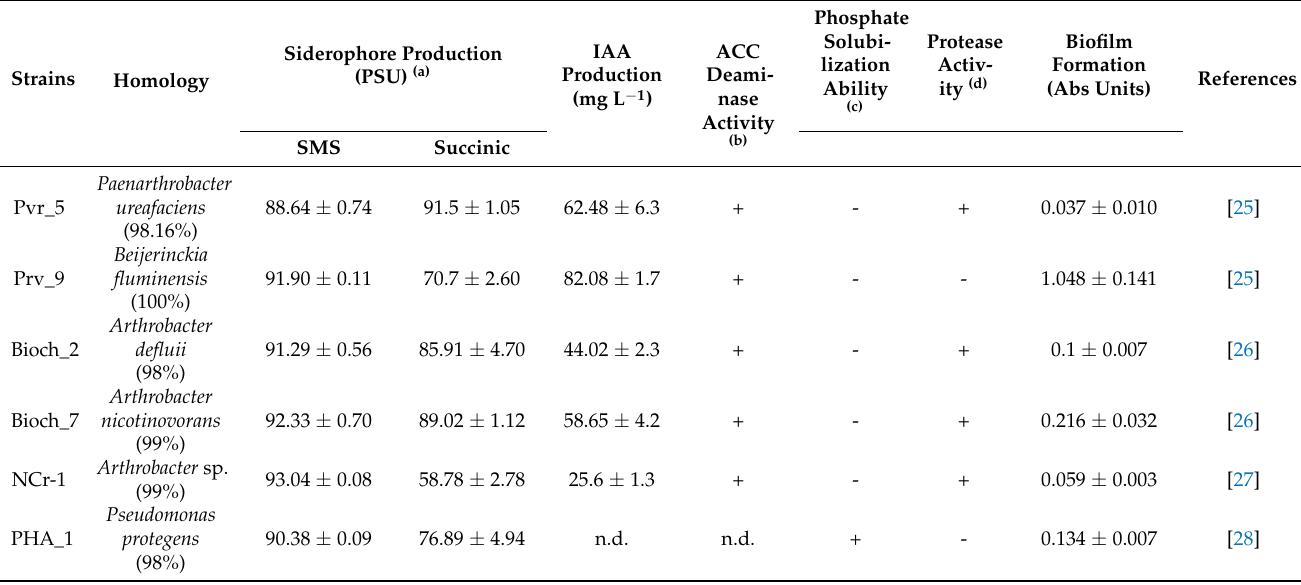
Table 1. Characteristics of PGPR bacteria strains isolated from different soil types, rhizosphere, and endosphere